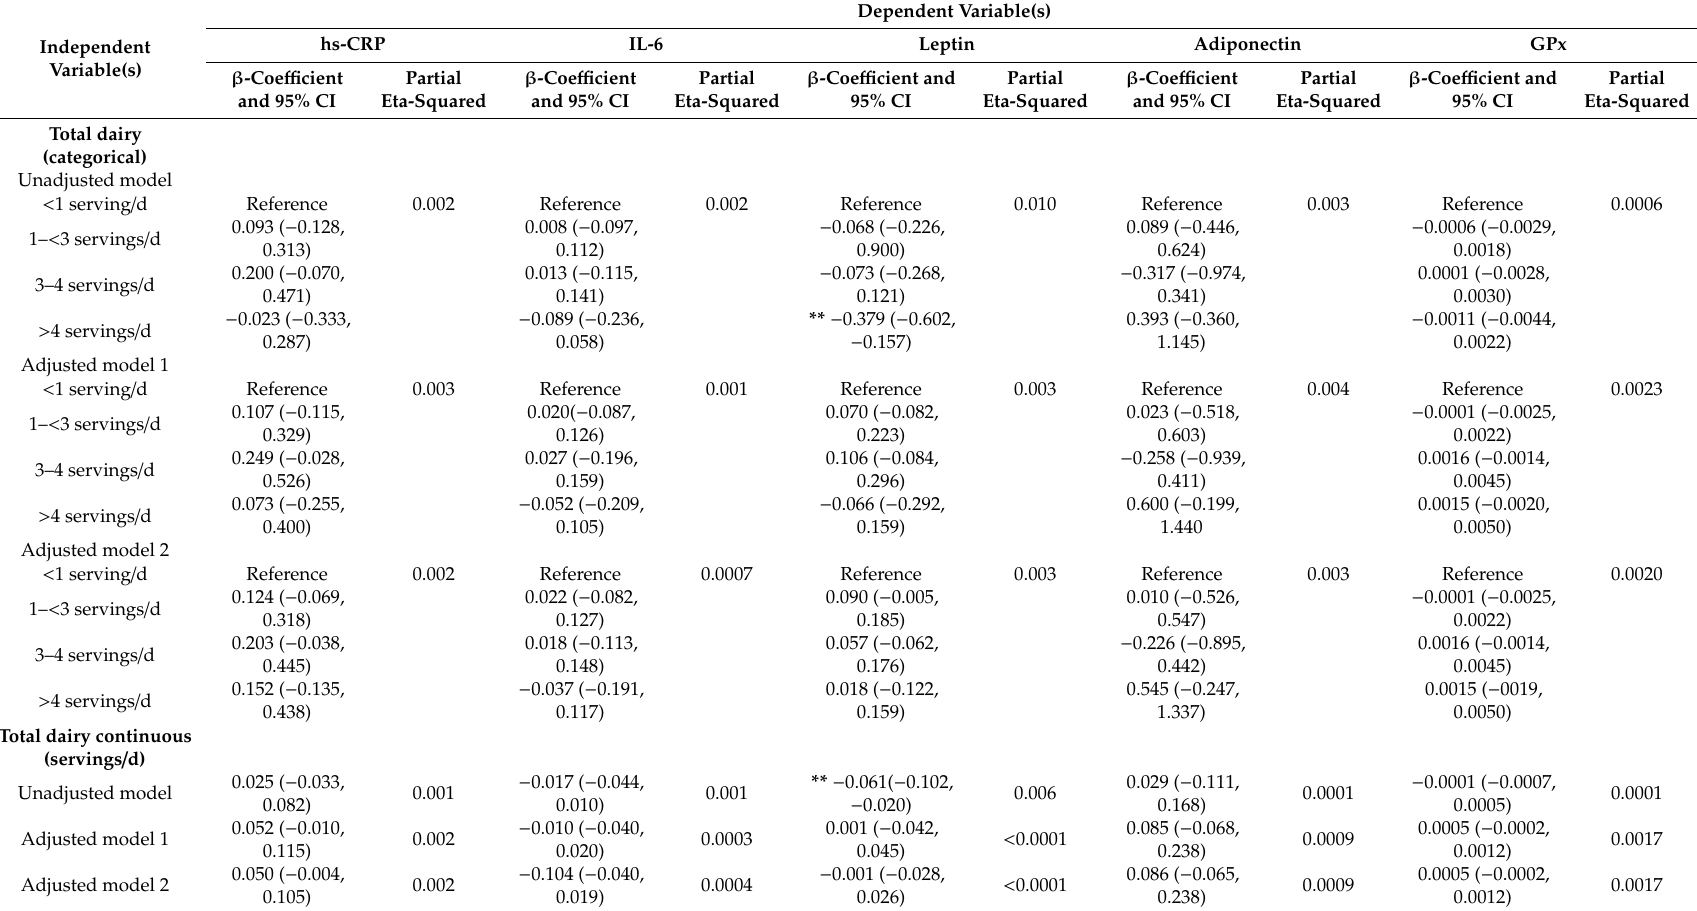
Table 2. Associations between total dairy consumption and markers of inflammation, adipocytokines, and oxidative